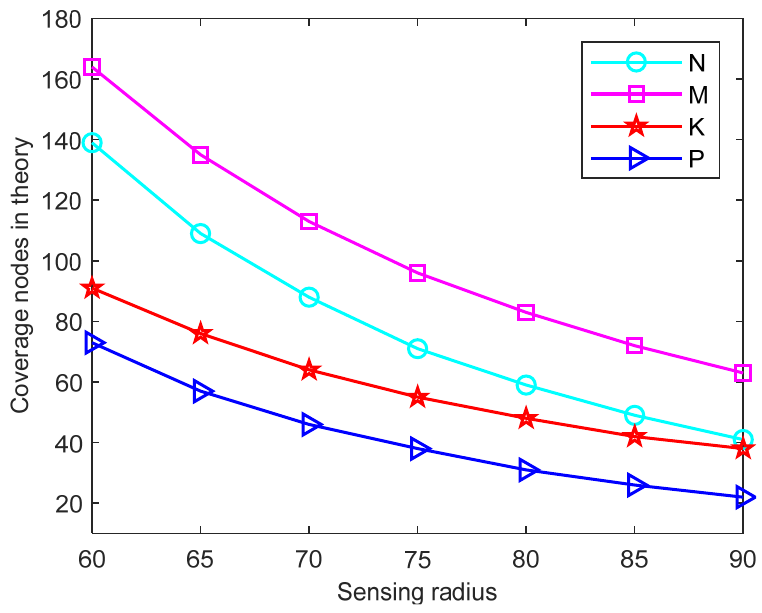
Figure 5. Coverage method analysis in theory.